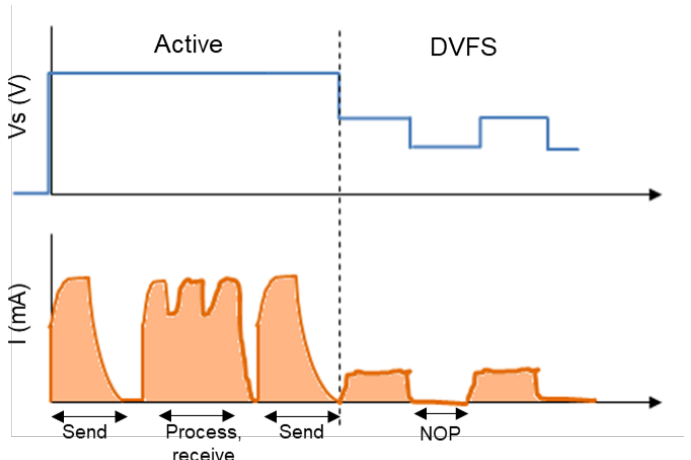
Figure 9. Drained current of the microcontroller during active mode (The dotted line defines the end of the active mode. The orange color presents the consumed current for each